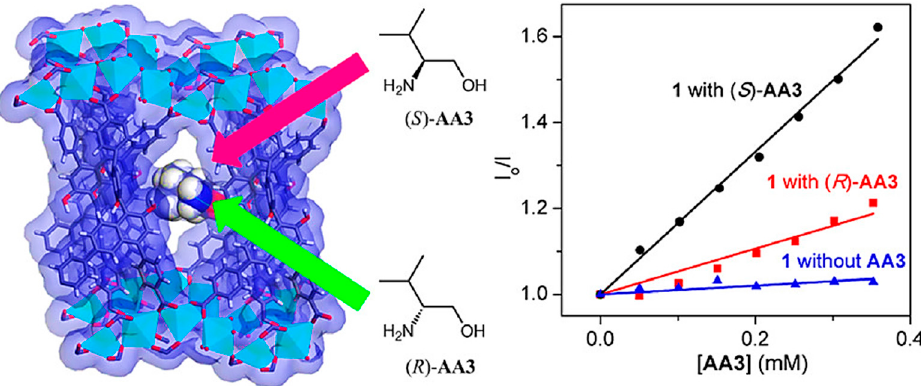
Figure 3. An illustration of analyte inside a synthesized fluorescent and highly porous MOF chan- nel and amino alcohol quenchers' chemical structures. As well as the Stern-Volmer plot for quencher 2-amino-3-phenylpropanol (AA3) added to CMOF. Reprinted (adapted) with permission from [56]. Copyright 2012 American Chemical Society.